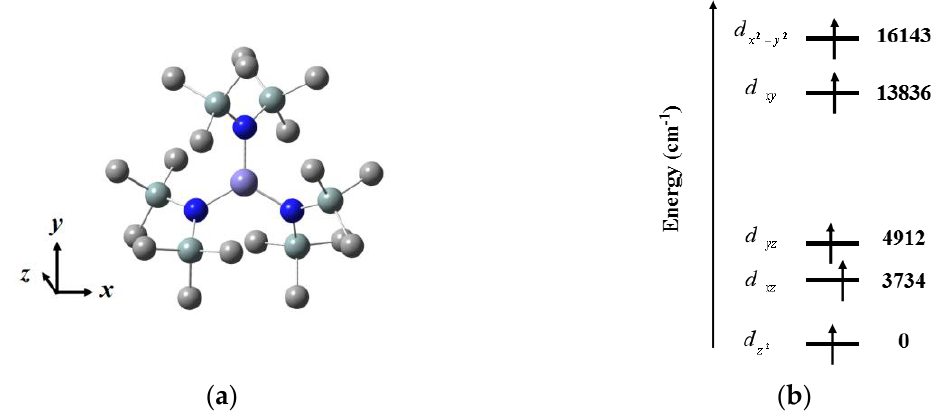
Figure 4. ( a ) Crystal structure of the Fe[N(SiMe 3 ) 2 ] 3 . Fe, purple; C, gray; N, blue. For clarity, all hydrogen atoms are omitted. ( b ) Calculated 3 d orbital energy for Fe[N(SiMe 3 ) 2 ] 3